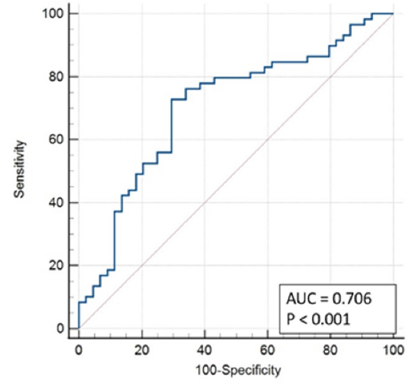
Figure 4. ROC Curve Model 1.